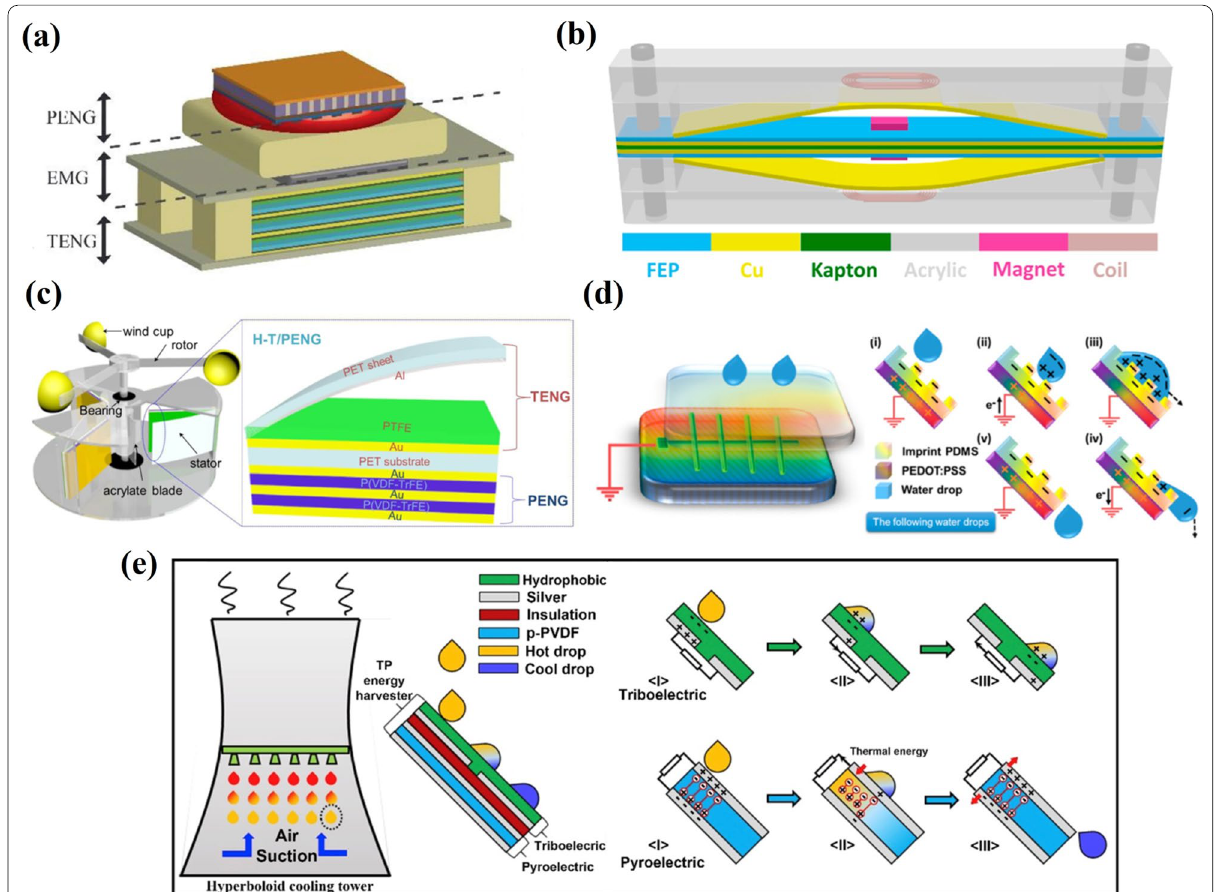
Fig. 16 Hybrid devices based on TENG. a Schematic illustration of the hybrid generator (Reproduced with permission from Ref. [105]). b Schematic diagram of the fabricated hybridized EM-TENG (Reproduced with permission from Ref. [106]). c Schematic illustration of the H-P/TENGs mounted in the custom frame and the enlarged structure of single H-P/TENG (Reproduced with permission from Ref. [107]). d Schematic illustration of a typical TENG structure and working mechanism of TENG (Reproduced with permission from Ref. [108]). e Schematic diagram of the TPENG and working principle of the triboelectric, and pyroelectric generators during interaction with a hot water droplet (Reproduced with permission from Ref.